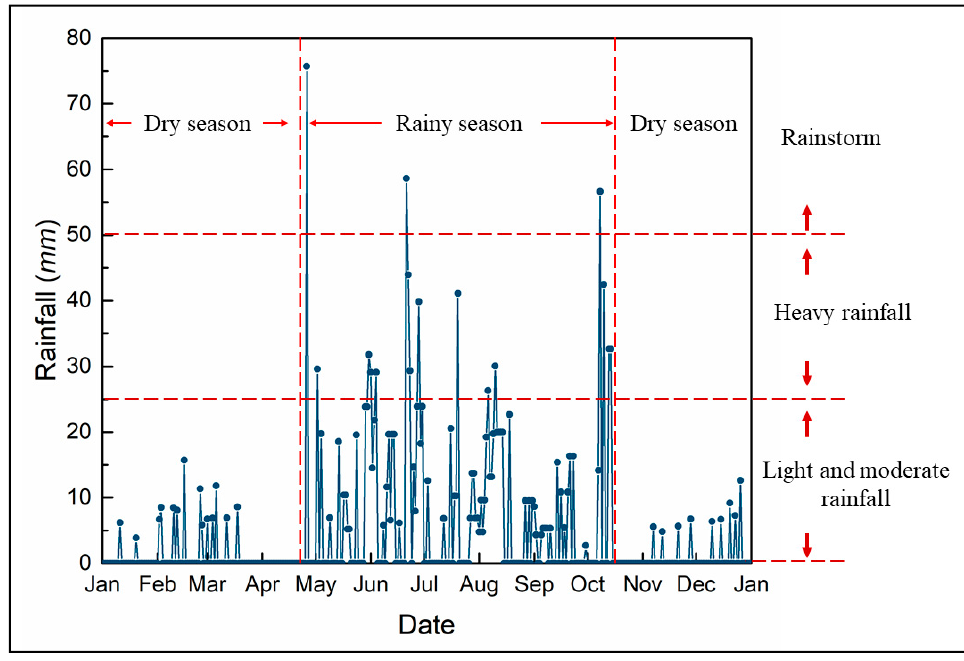
Figure 2. Rainfall data in the study area (National Meteorological Information Center).